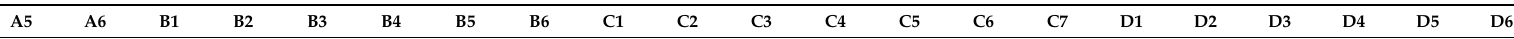
Table 5. Correlation